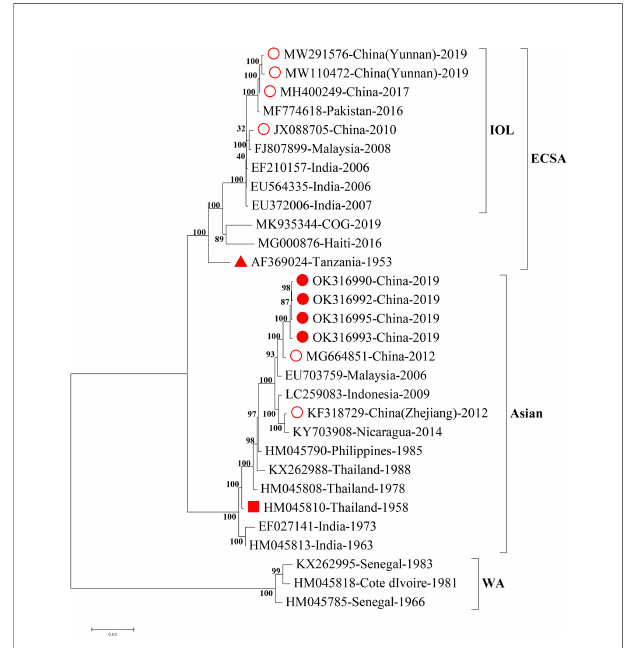
FIGURE 2 | Phylogenetic analysis of the full length of CHIKV genomic sequences. Nearly complete sequences of representative CHIKV strains from each genotype were downloaded from NCBI GenBank database. Alignment and comparison were conducted to screen the genomic sequences with more than 59 bp at 5 ’ UTR and more than 407 bp at 3 ’ UTR for further phylogenetic analysis using MEGA7 maximum likelihood method with 500 bootstrap values. Representative strains of each genotype in the phylogenetic tree were named by accession number, country of origin, and year of isolation. The numbers on the branches of phylogenetic tree represent the posterior probability values. The red circles represent CHIKV strains isolated in China, the red dots for CHIKV strains isolated in this study, the red triangles for the earliest ECSA isolate S27, and the red squares for the earliest Asian isolate. The tree is drawn to scale, with branch lengths measured in the number of substitutions per site. CHIKV, chikungunya virus; WA, West African; ECSA, East/Central/South African; IOL, Indian Ocean